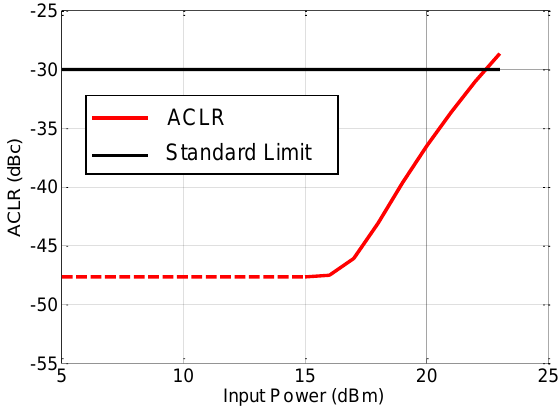
Figure. 15. Measured ACLR versus input power with a LTE 16 QAM 10 MHz signal at 770 MHz ACLR is measured for different TC states and frequencies using an LTE 16 QAM 10 MHz uplink signal. Table I summarizes the linearity performance of the tunable antenna.